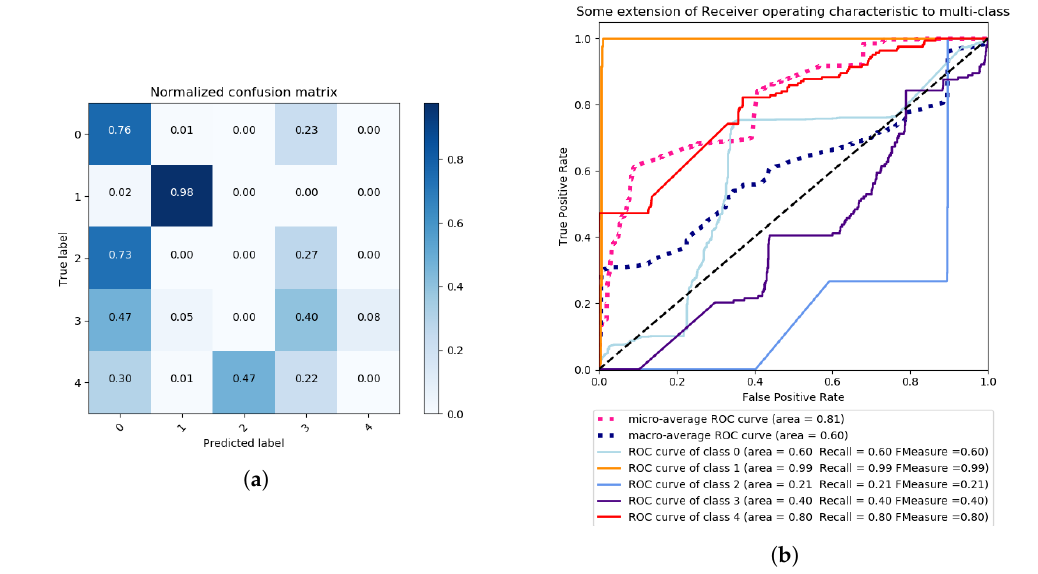
Figure 6. Multi-class problem—Grid Search SVM with: sigmoidal Kernel, One vs. Rest decision function shape, 30 iterations, and a scoring criterion of accuracy, confusion Matrix ( a ) and ROC Curves ( b